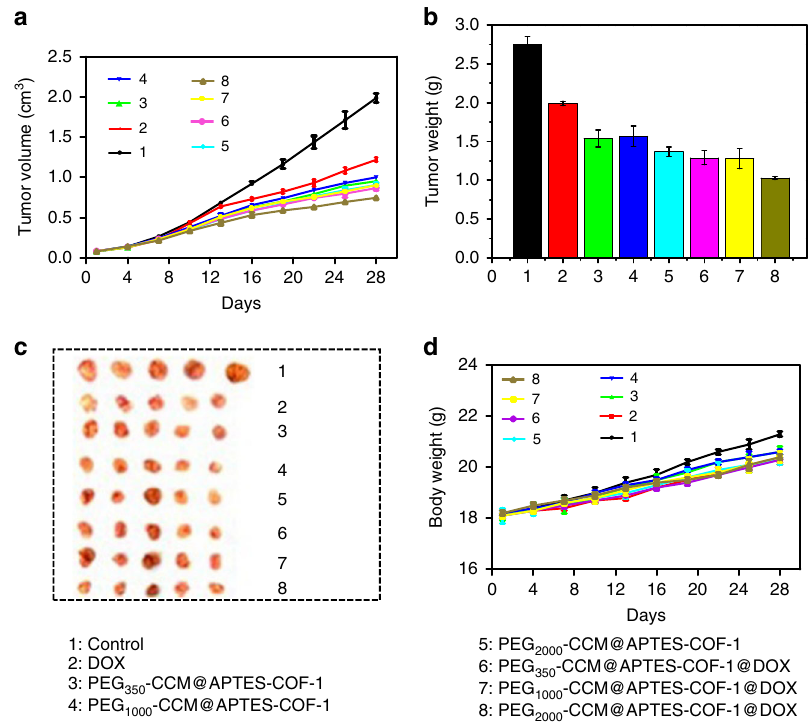
Fig. 5 In vivo evaluation of antitumor ef fi cacy. a Mean tumor volumes and b mean tumor weights after excision at day 28 ( n = 5). c Representative photographs of mice tumors after treatment and d body weights of the mice in different groups after treatment at different time intervals. Relative antitumor assay after intravenous injection into the HeLa tumor-bearing mice with saline, free DOX, PEG 350 -CCM@APTES-COF-1, PEG 1000 -CCM@APTES- COF-1, PEG 2000 -CCM@APTES-COF-1, PEG 350 -CCM@APTES-COF-1@DOX, PEG 1000 -CCM@APTES-COF-1@DOX, and PEG 2000 -CCM@APTES-COF- 1@DOX at an equivalent dose of 1.5 mg DOX kg − 1 in PBS every 3 days. Data were presented as the mean ± SD ( n = 5). Each data point represents the average and SD (one above and one below for the error bars), as measured from fi ve different analysis in a single